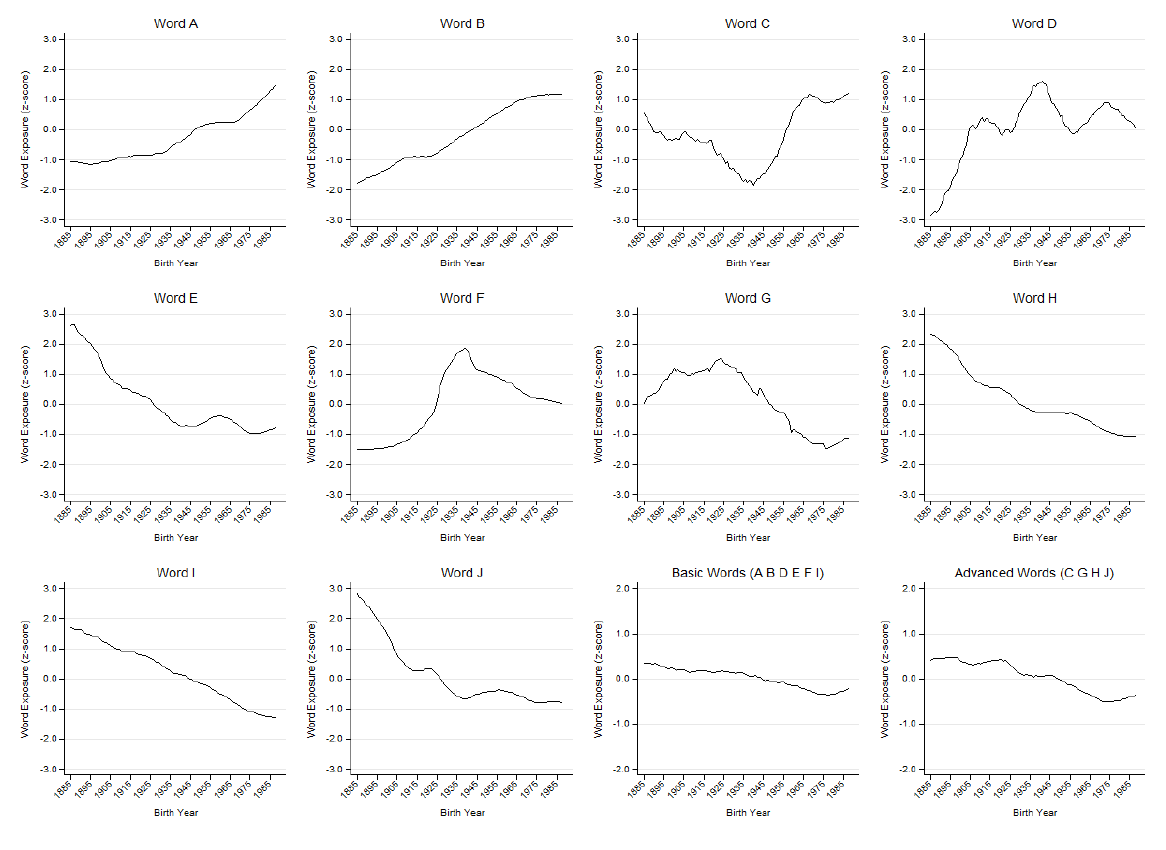
Figure 3: Trends in cohort exposure to WORDSUM test items in books: